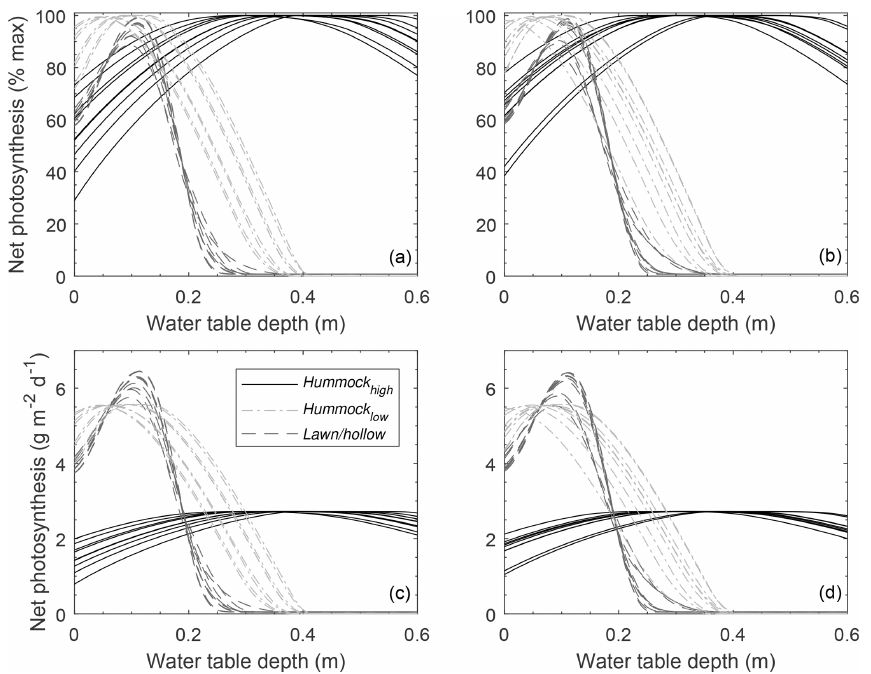
Figure 8. Plots-scale mean potential net photosynthesis (NP) for three microtopographic classes (i.e. high-hummock, low-hummock, and lawn/hollow; see Fig. S4) derived from spatially explicit elevation data for random (a, c) and qualitatively chosen (b, d) plots. NP-WC and WC-WTD relations are based on separate parameterization for each microtopography class (see Fig.